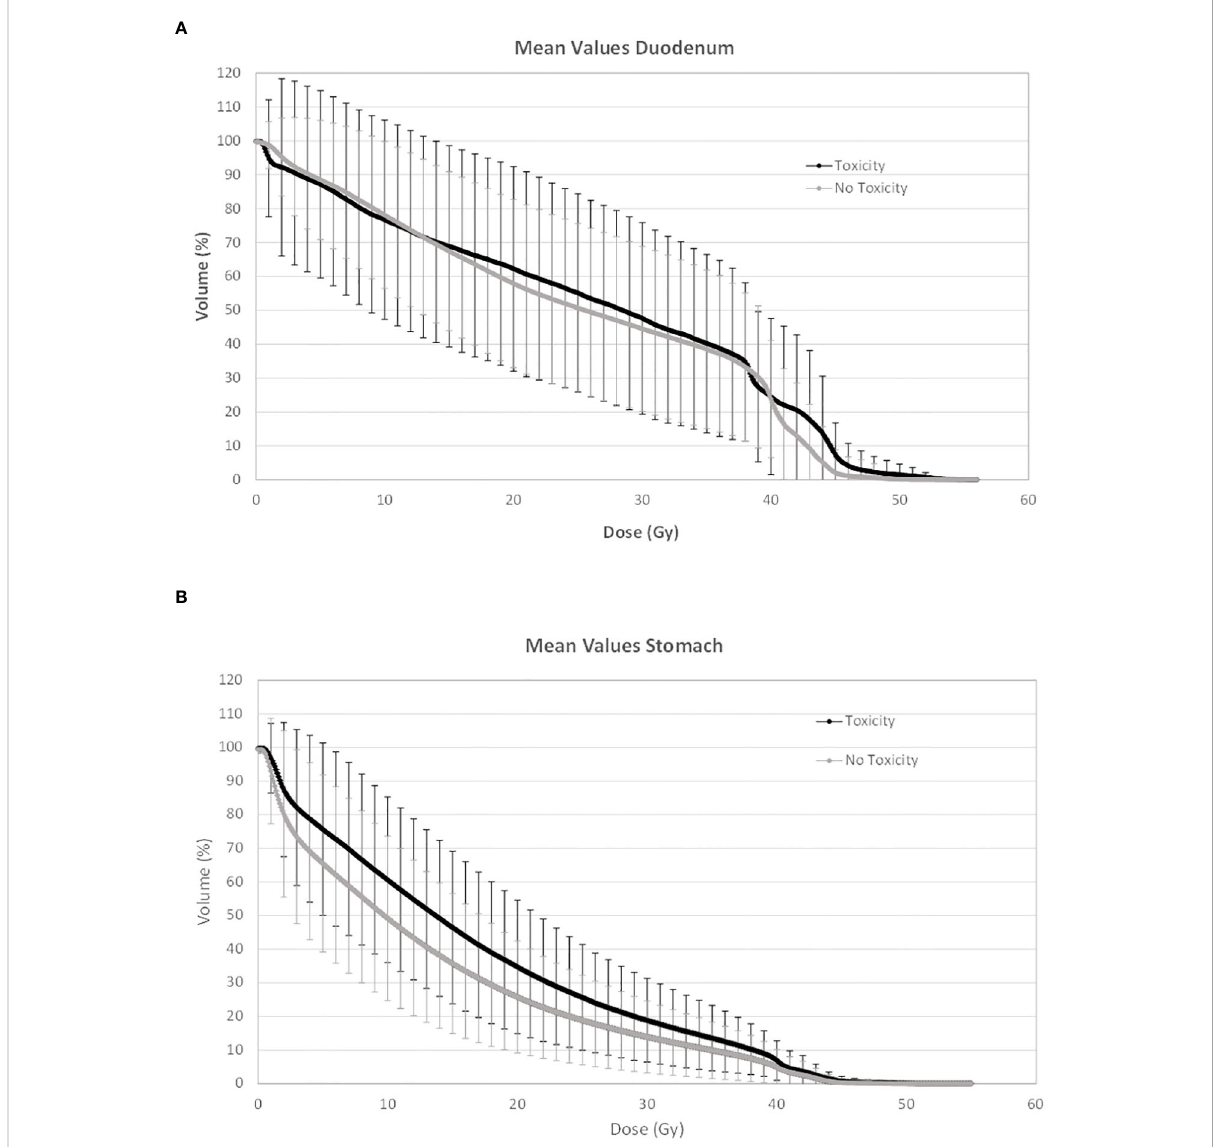
FIGURE 2 Average percentage DVH for duodenum (A) and stomach (B) for patients with and without toxicities. DVH, dose – volume